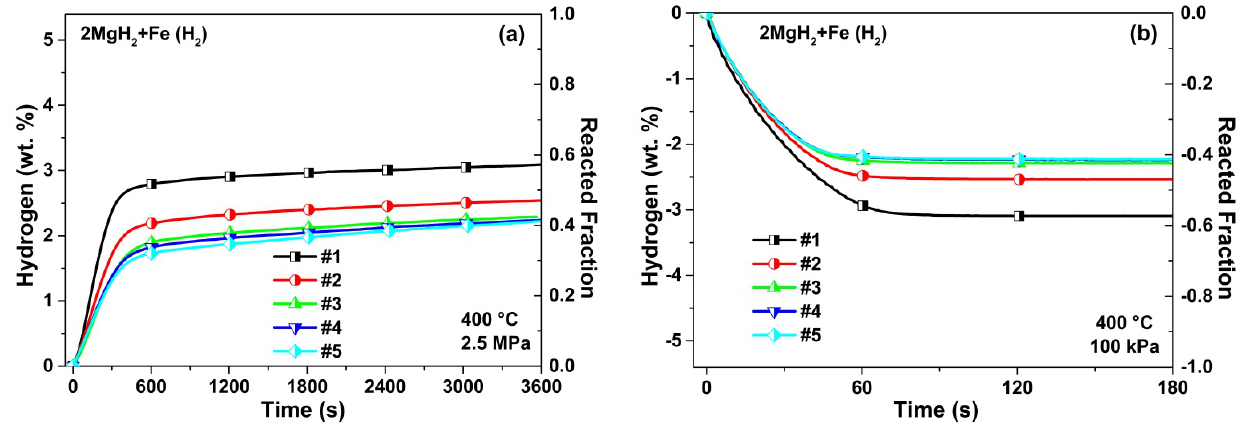
Figure 7. Kinetic curves of hydrogen ( a ) absorption and ( b ) desorption at 400 °C of 2MgH + Fe (H ) sample. The hydrogen absorption and desorption were respectively 2 2 measured under 1.7 MPa and 100 kPa of H 2